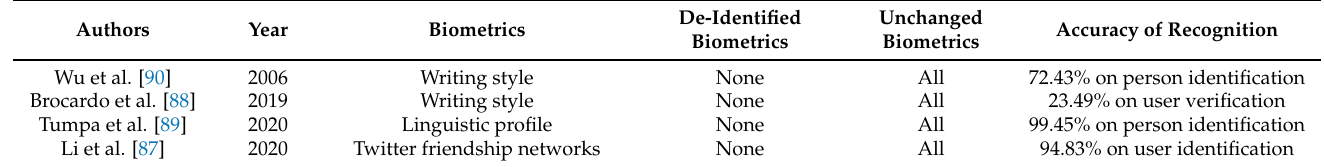
Table 7. Summary of social behavioral biometrics-based identification